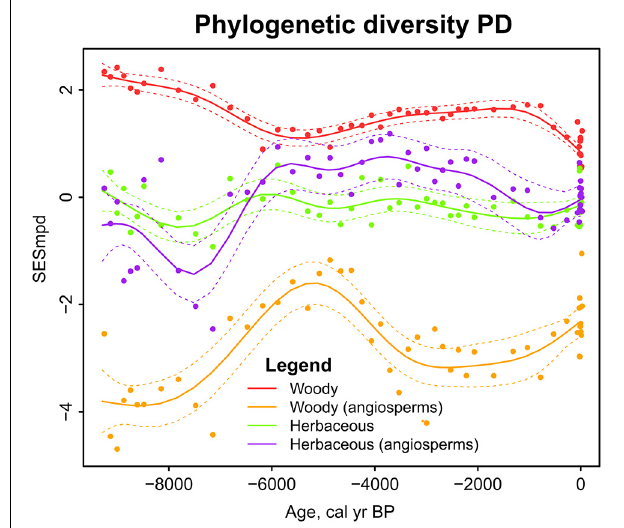
FIGURE 7 | Sedimentary pollen based reconstruction of phylogenetic diversity (PD) in Kanna spring fen. Generalized additive models in relation to time. Dashed lines enclose the 95% confidence intervals of trend